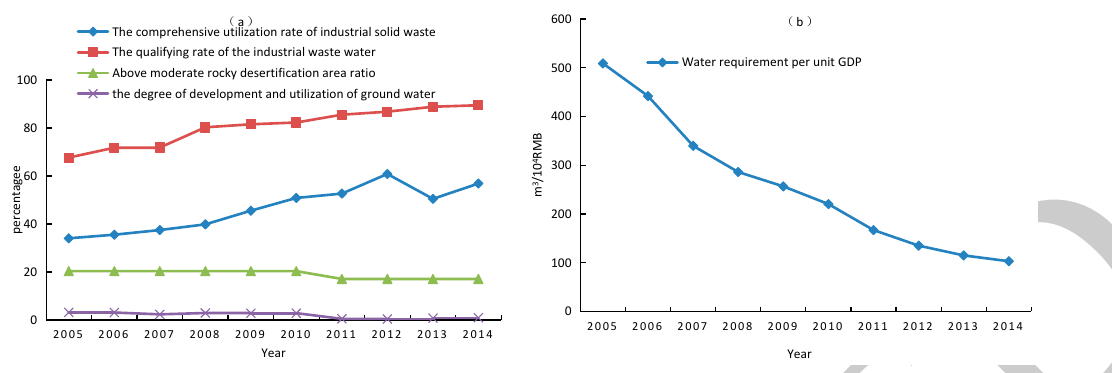
Figure 6. Driving factors of water resource security in the karst area. ( a ) The comprehensive utilization rate of industrial solid waste, the qualifying rate of the industrial waste water, above moderate rocky desertification area ratio and the degree of development and utilization of ground water; ( b ) Water requirement per unit GDP.